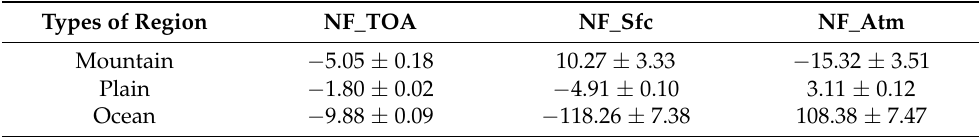
Table 5. The annual mean values of net fluxes for the three regions in Figure 6, during the year of 2021. Unit of net flux: W · m − 2 , positive and negative sign indicates the atmospheric warming and cooling, respectively, and values after “ ± ” refer to the standard